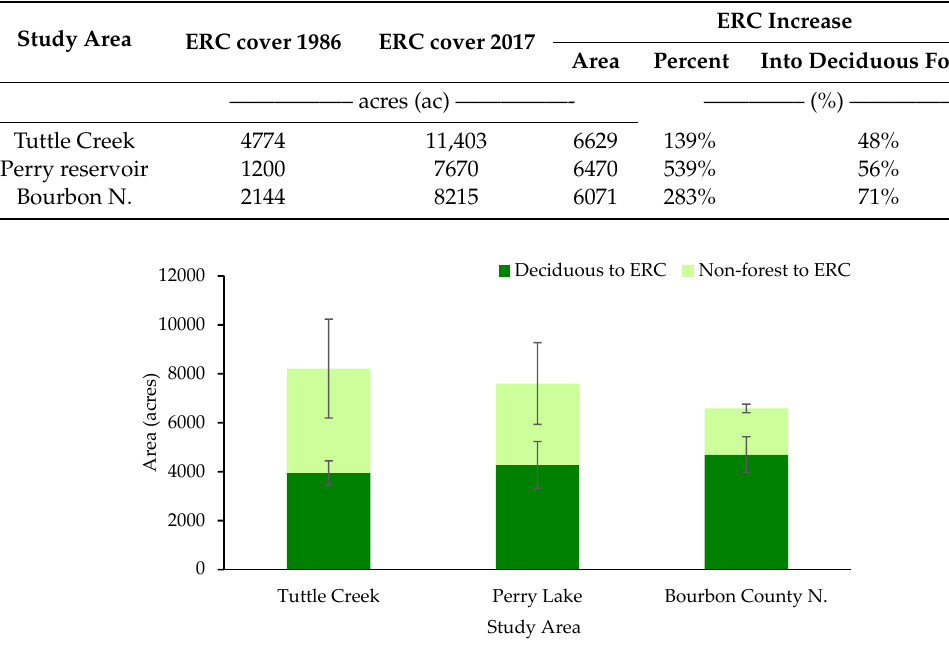
Table 6. Thirty-year ERC change within the three study areas.